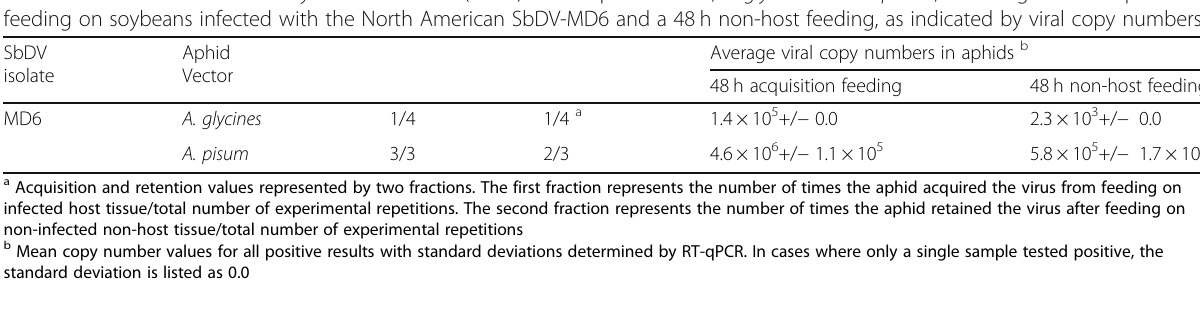
Table 1 The concentration of Soybean dwarf virus (SbDV) in the aphid vectors, A. glycines and A. pisum , following a 48 h acquisition feeding on soybeans infected with the North American SbDV-MD6 and a 48 h non-host feeding, as indicated by viral copy numbers SbDV isolate